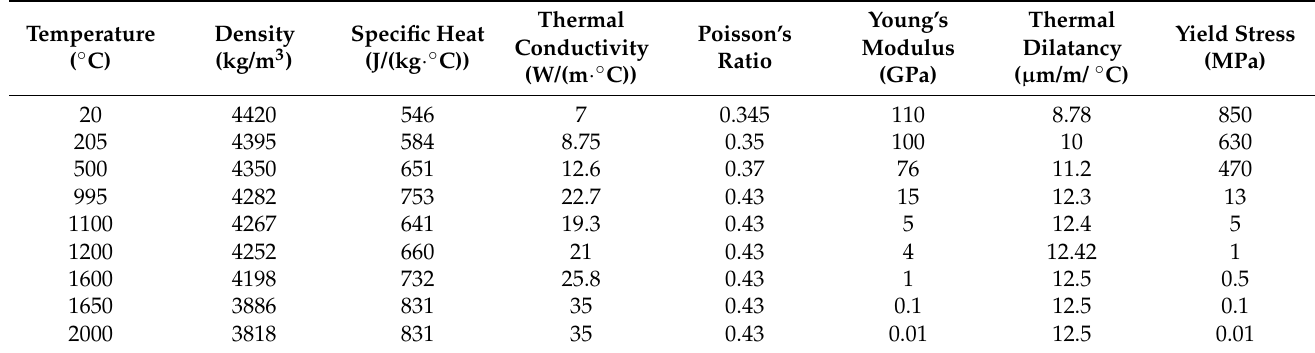
Table 4. Temperature-dependent material properties of Ti-6Al-4V alloy [5].